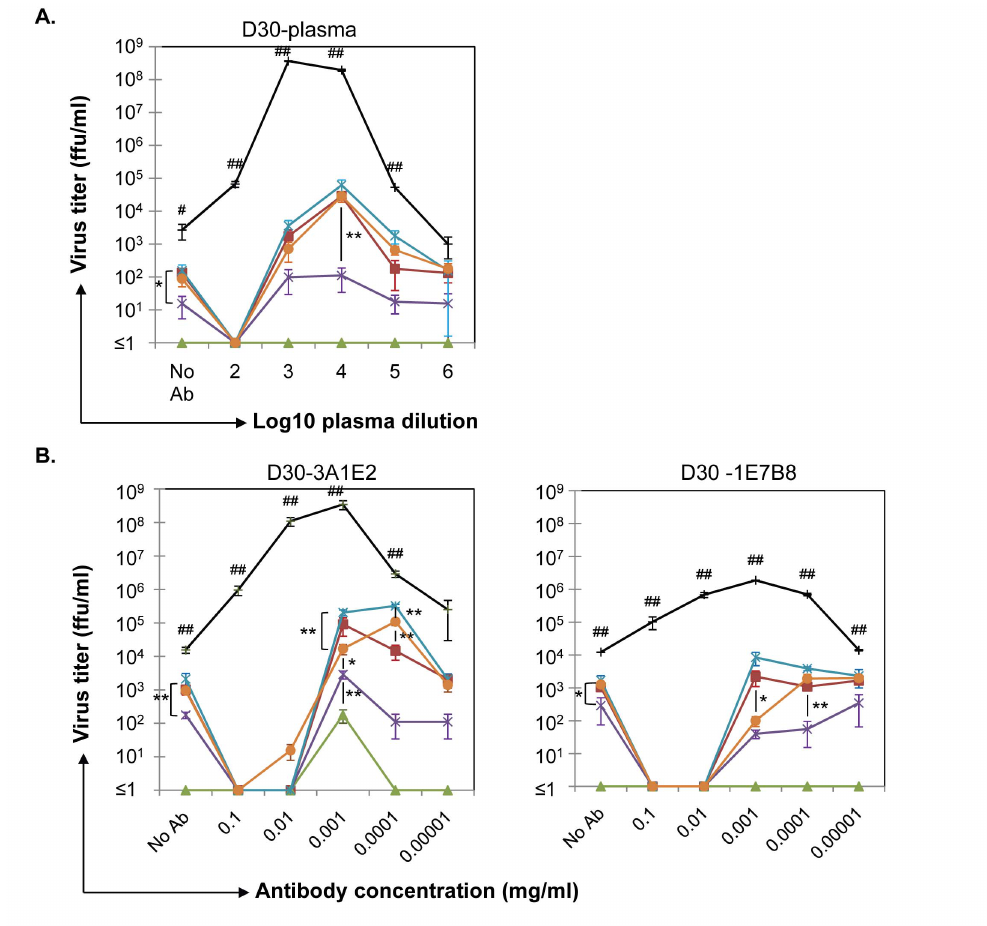
Figure 5. ADE levels of recombinant DENVs or DENV-2 strain 16681 exposed to D30-plasma or HuMAbs. A heat-inactivated D30- plasma sample (A) or purified human MAbs derived from patient D30 (B) were serially diluted 10-fold in RPMI-1640 medium and incubated with either DENV-2 16681 or individual recombinant DENVs for 30 min at an MOI of 0.1. Virus-antibody complexes were added to K562 cells and incubated for a further 2 h; maintenance medium was then added (without washing the cells) to yield a FBS final concentration of 2%. Cells and supernatants were collected on Day 3 post-infection. Virus titers in the supernatants were determined in focus-forming immunoassays in Vero cells. Results are expressed as the mean 6 SD from two independent experiments performed in triplicate (* p , 0.05 and ** p , 0.01 , unpaired two-tailed Student t-test, n=3 per point). Statistically significant differences between data points are indicated by # ( # p , 0.05 , ## p , 0.01 ).